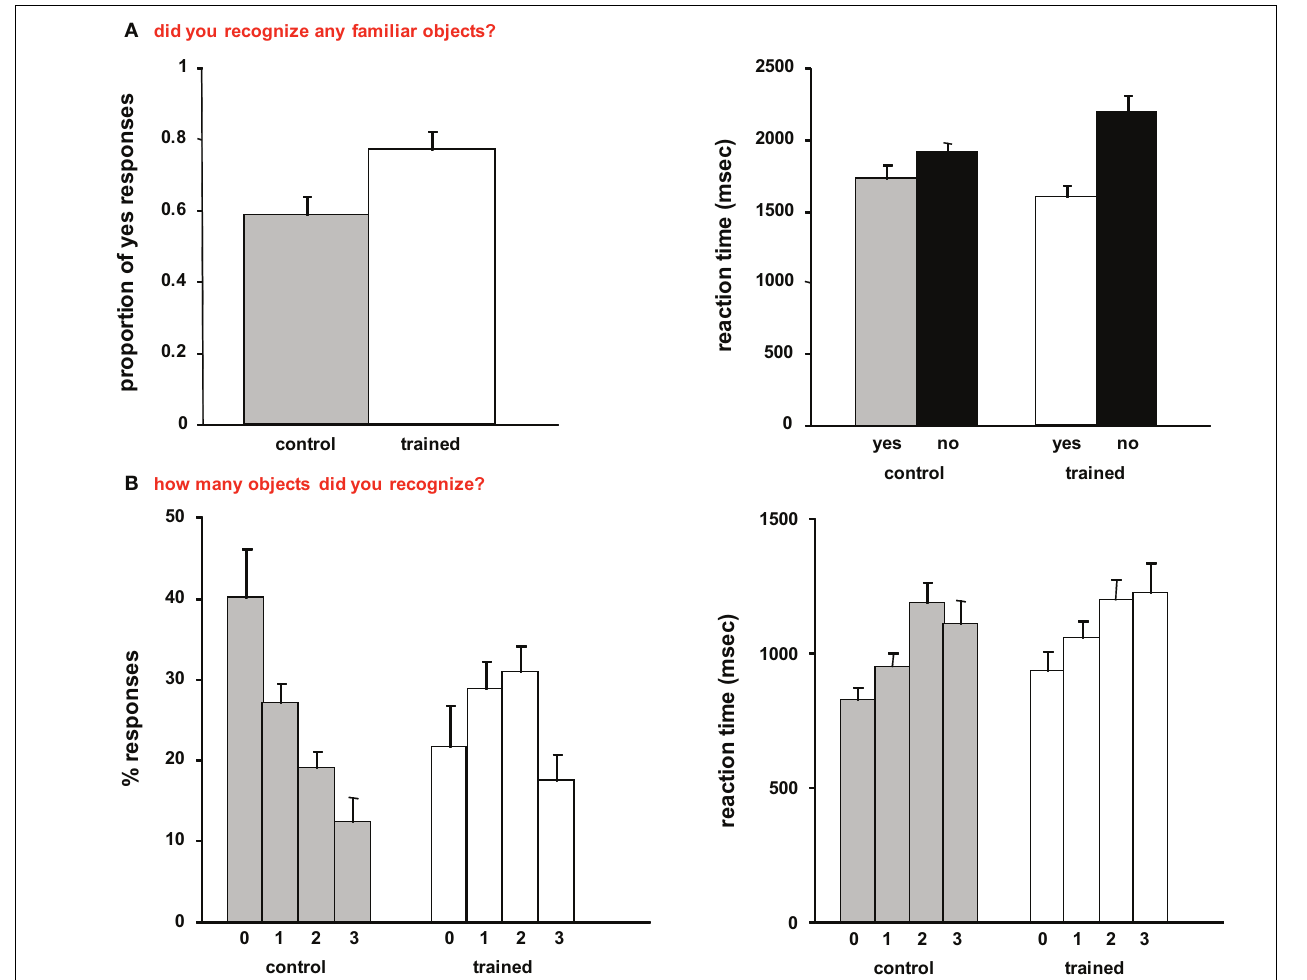
FIGURE 1 | Behavioral data. (A) Mean responses and reaction times recorded during the fi rst task (“did you recognize any familiar objects?”). (B) Mean responses and reaction times recorded during the second task (“how many familiar objects did you recognize?”). In this and subsequent graphs, error bars indicate standard error of the mean